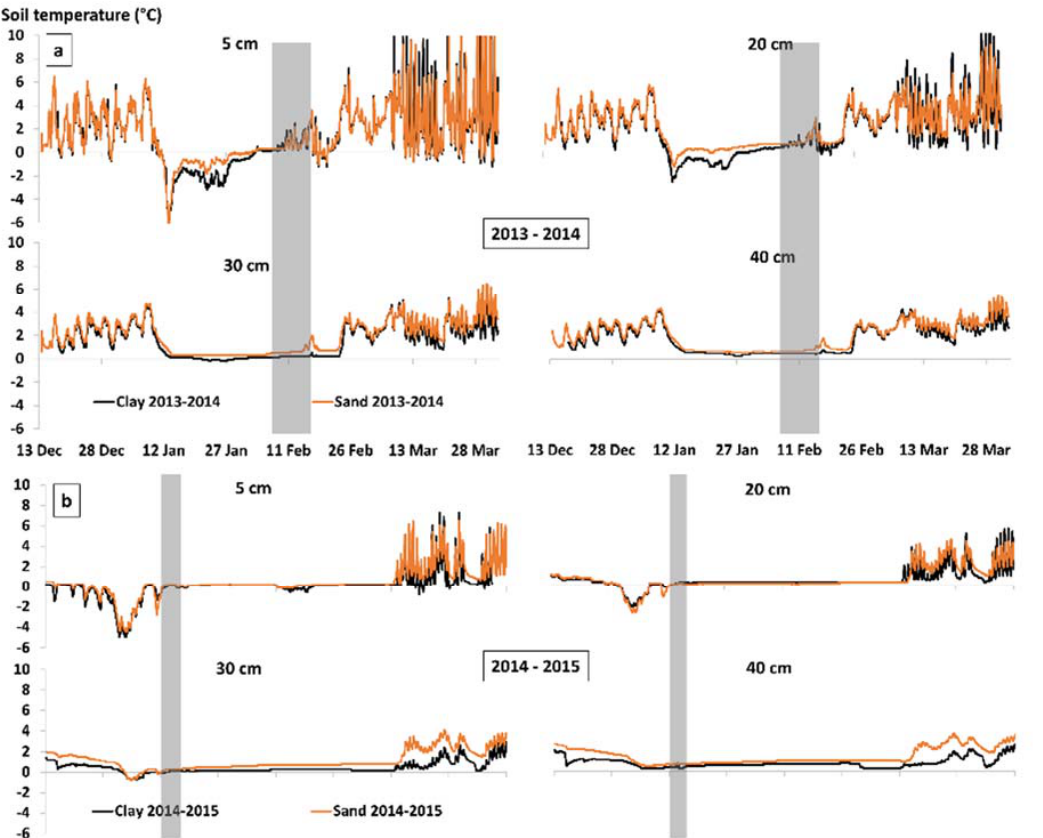
Figure 5. Measured soil temperature in the clay and sand for the winter periods 2014 ( a ) and 2015 ( b ) at four depths: 5, 20, 30 and 40 cm. Durations of the rain events of interest (according to Table 2) are marked with grey bands.